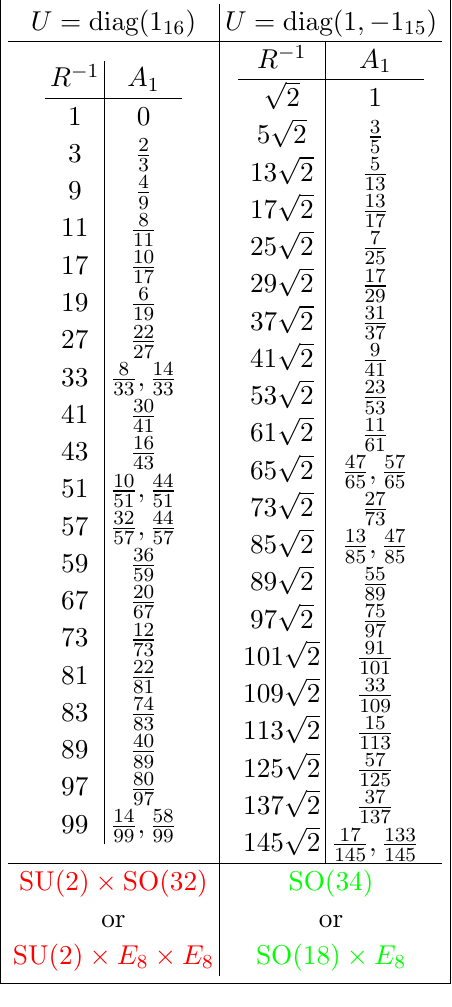
Table 4. Fixed points of the dualities O U